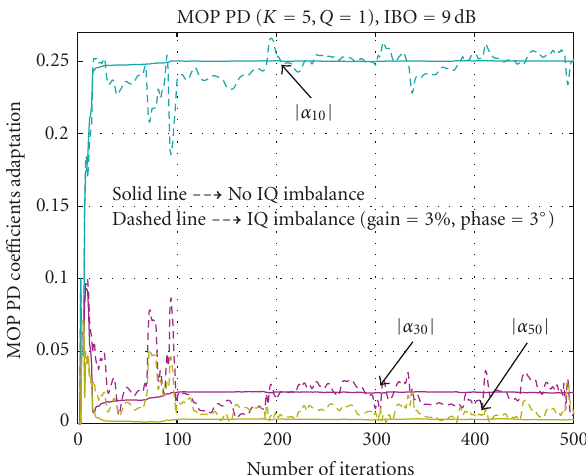
Figure 3: Convergence behavior of the MOP PD coe ffi cients adaptation with and without IQ